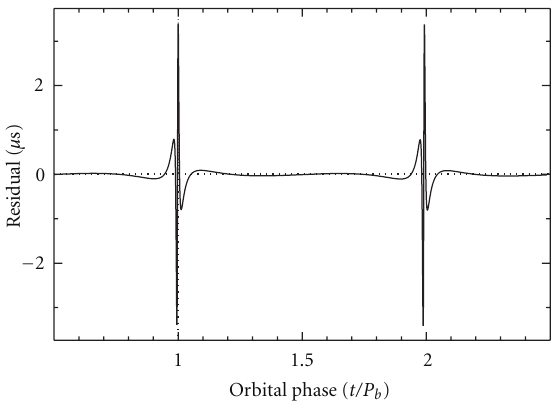
Figure 7: Typical timing residuals for a radio pulsar in an orbit around a black hole with a mass of 10 4 M (cid:7) due to the presence of a nonvanishing quadrupole moment [31]. For Sgr A ∗ , such residuals will have a similar shape but with a larger